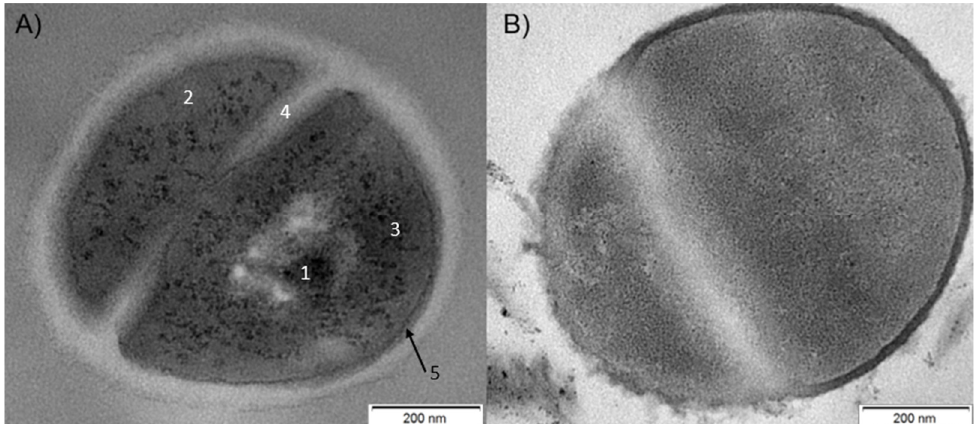
Figure 4. Transmission electron microscopy (TEM) images of S. aureus cells; ( A ) negative